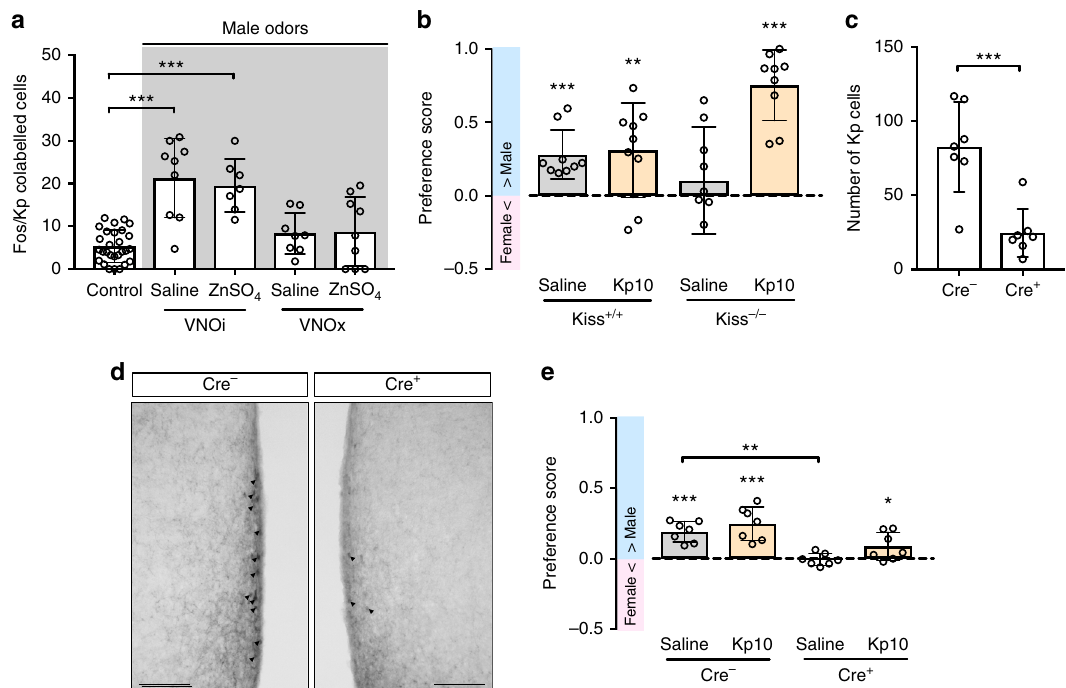
Fig. 1 RP3V kisspeptin neurons are part of a motivational circuit triggered by male olfactory cues. a Removal of the vomeronasal organ (VNOx) but not ablation of the main olfactory epithelium by intranasal infusion of a zinc sulfate solution (ZnSO 4 ) with the vomeronasal organ intact (VNOi) disrupted male odor-induced activation of RP3V kisspeptin neurons as determined by the percentage of Fos/Kp co-labeled cells. *** P ≤ 0.001; Dunn ’ s multiple comparison test; n = 28/9/7/8/9. b Kisspeptin knockout ( Kiss − / − ) female mice do not show a male-directed preference, whereas female control littermates displayed a preference for the male. Strikingly, a single peripheral injection with kisspeptin (Kp-10) at a dose of 0.52 µ g kg − 1 induced a very strong preference for